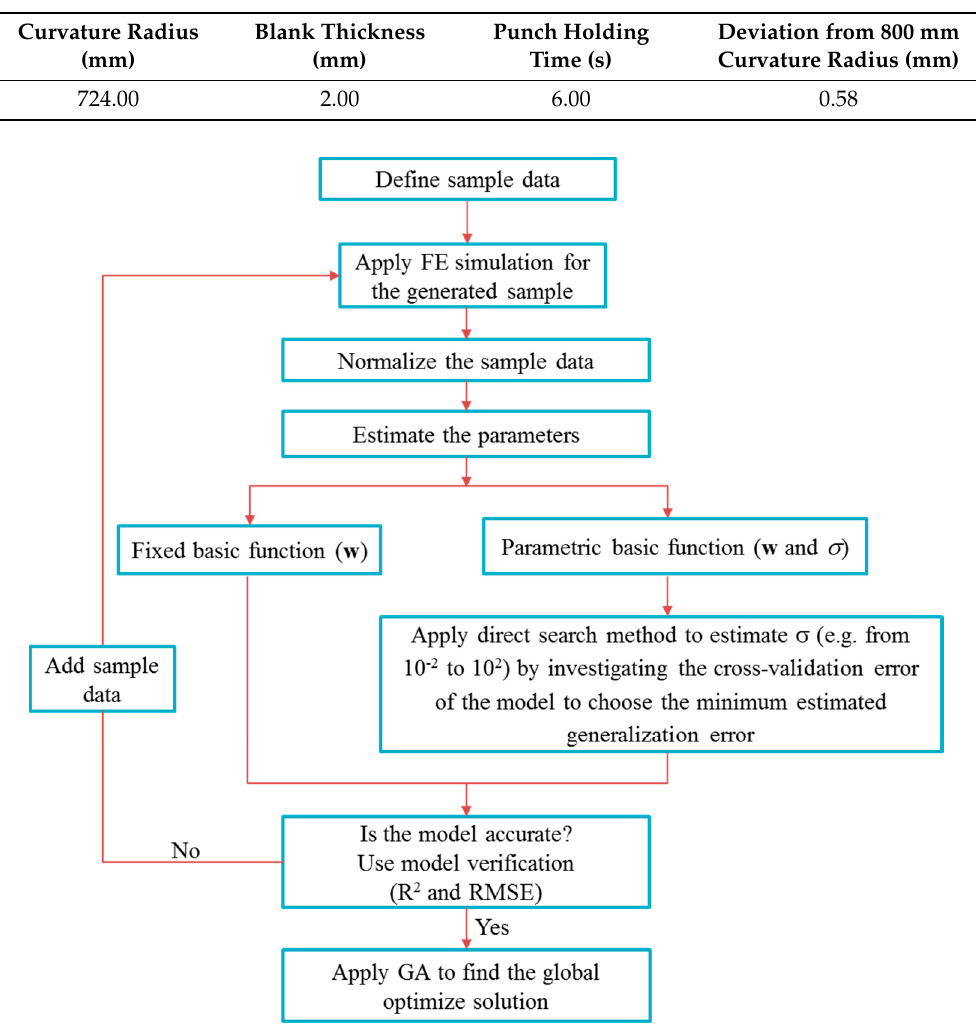
Table 5. Optimal result.